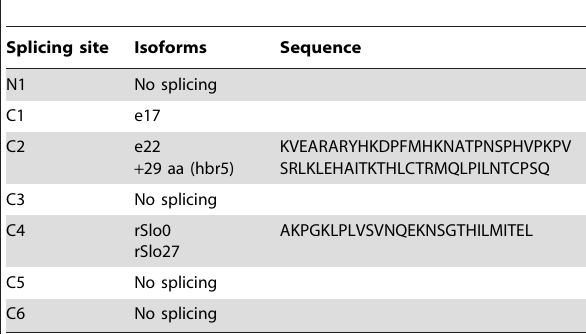
Table 1. Splicing sites and relative amino acid sequences of rat Soleus (Sol) and Flexor digitorum brevis (FDB) muscles Kcnma1 gene.